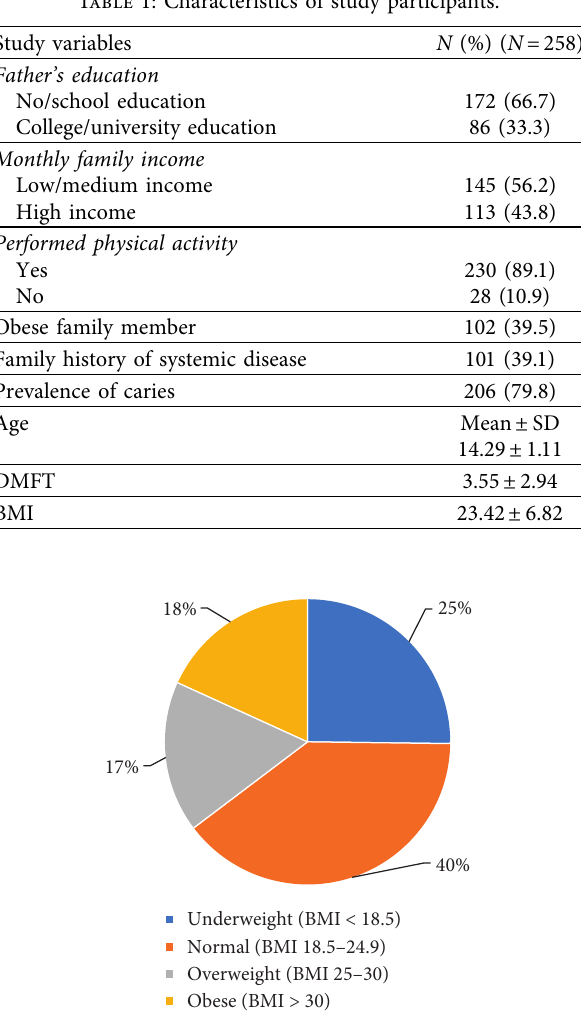
Figure 1: Distribution of participants according to four categories of